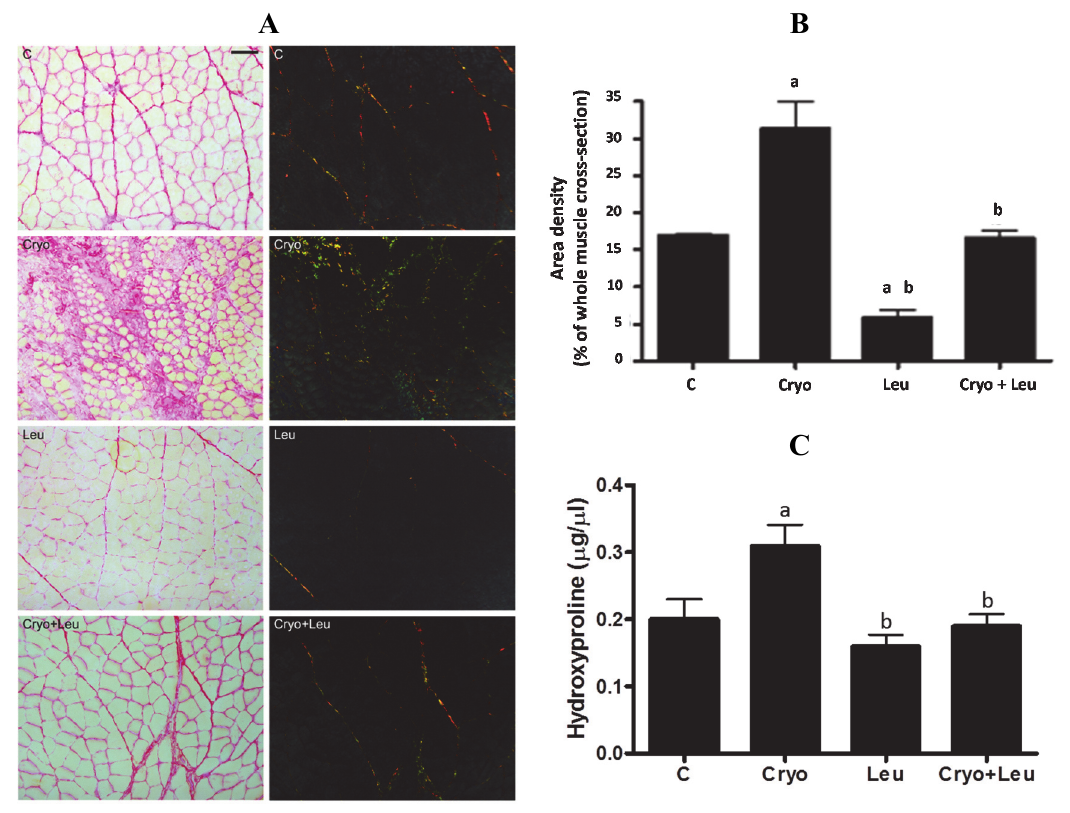
Figure 5. TA muscle cross-sections stained with Sirius red and analyzed under light and polarized microscopes (cross-sections on left and right, respectively, ( A )). Scale bar = 50 µm. Area density of connective tissue from TA muscles stained with Sirius red ( B